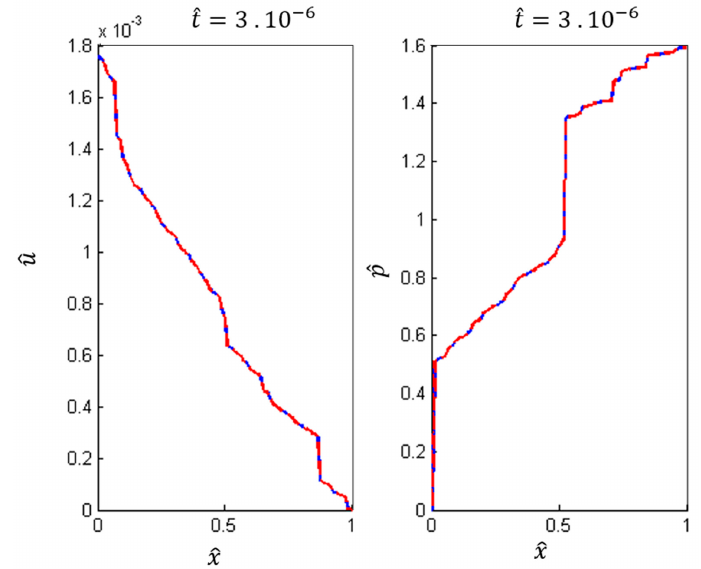
Figure 8. Comparison of the displacement (left) and pore pressure at time ˆ t = 3 × 10 − 6 with hybrid splitting (continuous blue line) and fully coupled (discontinuous red line) methods with nine iterations for random material coefficients.